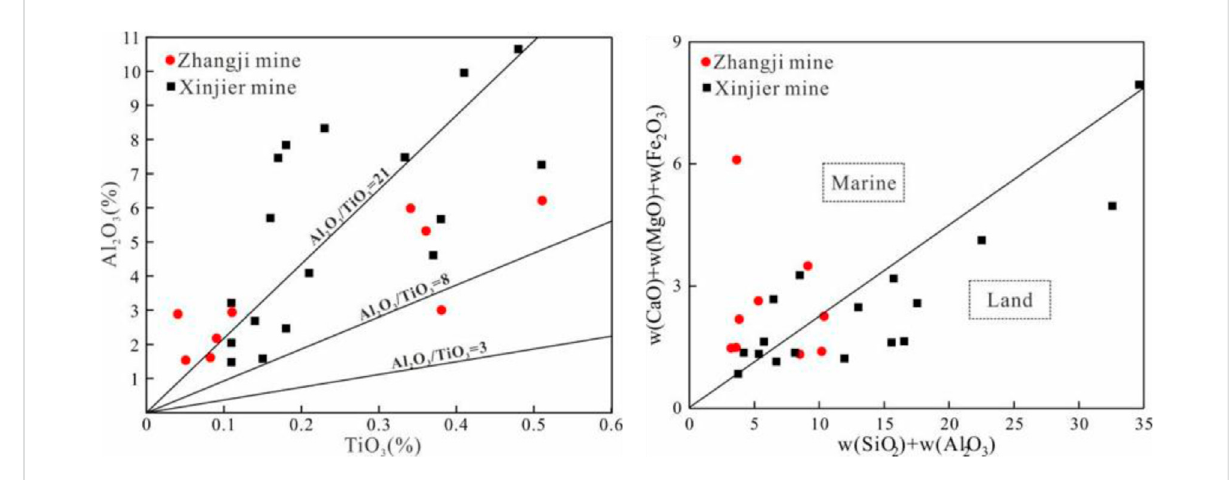
FIGURE 4 Lithological parameters and sedimentary environment ratio.